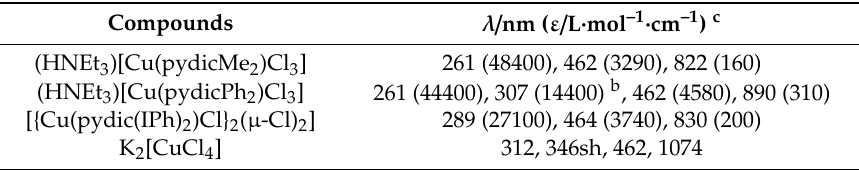
Table 4. Absorption maxima for Cu II complexes a .